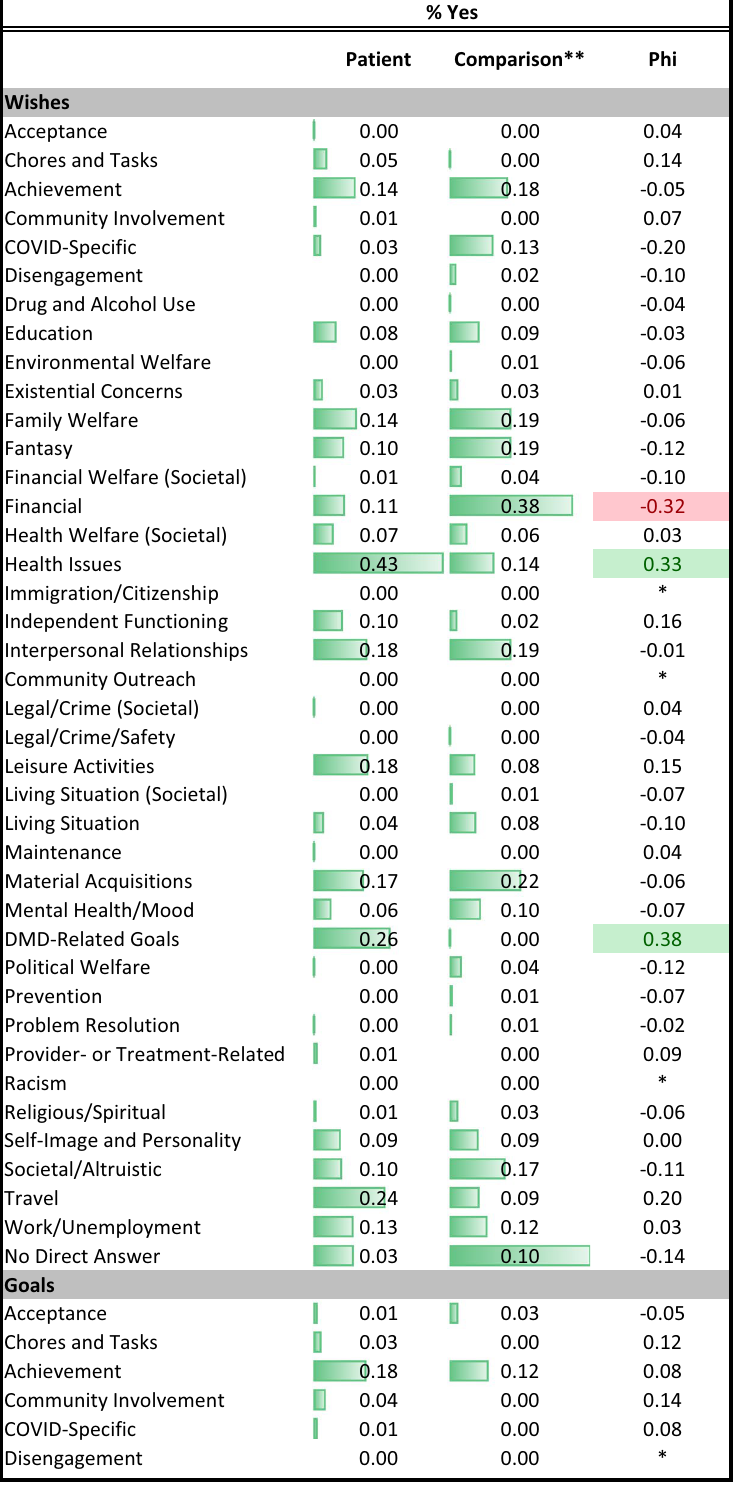
Table 2 Descriptive statistics for themes from open-text